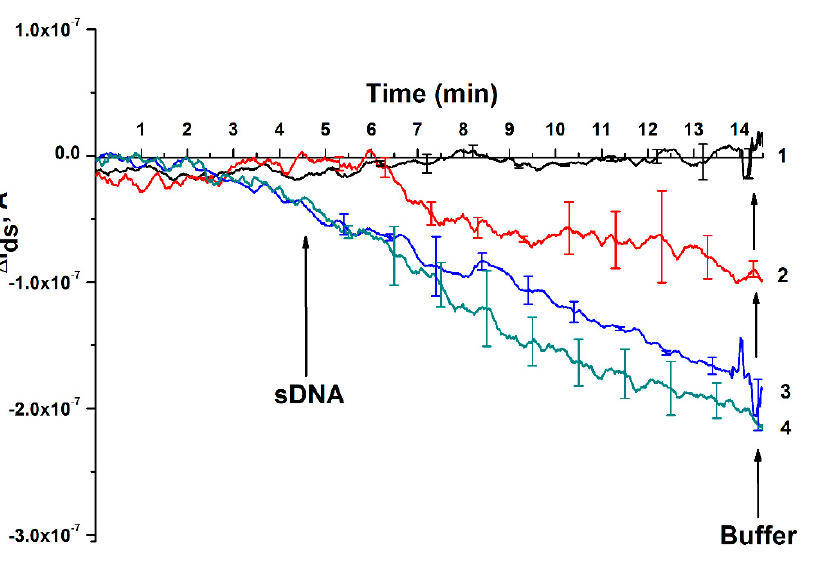
Figure 5. Results of target sDNA detection at various concentrations in a buffer solution employing a nanoribbon biosensor. Legend: sDNA concentration is C = 1.1 × 10 − 18 M (1); C = 1.1 × 10 − 17 M (2); C = 1.1 × 10 − 16 M (3); C = 1.1 × 10 − 15 M (4). The experiment was carried out in a working 1 mM PPB (pH 7.4), V ds = 0.2 V, V g = 50 V; solution volume was 450 µL. The number of technical repetitions is three. The arrows indicate the moments of adding the target sDNA solution and the potassium-phosphate wash buffer.